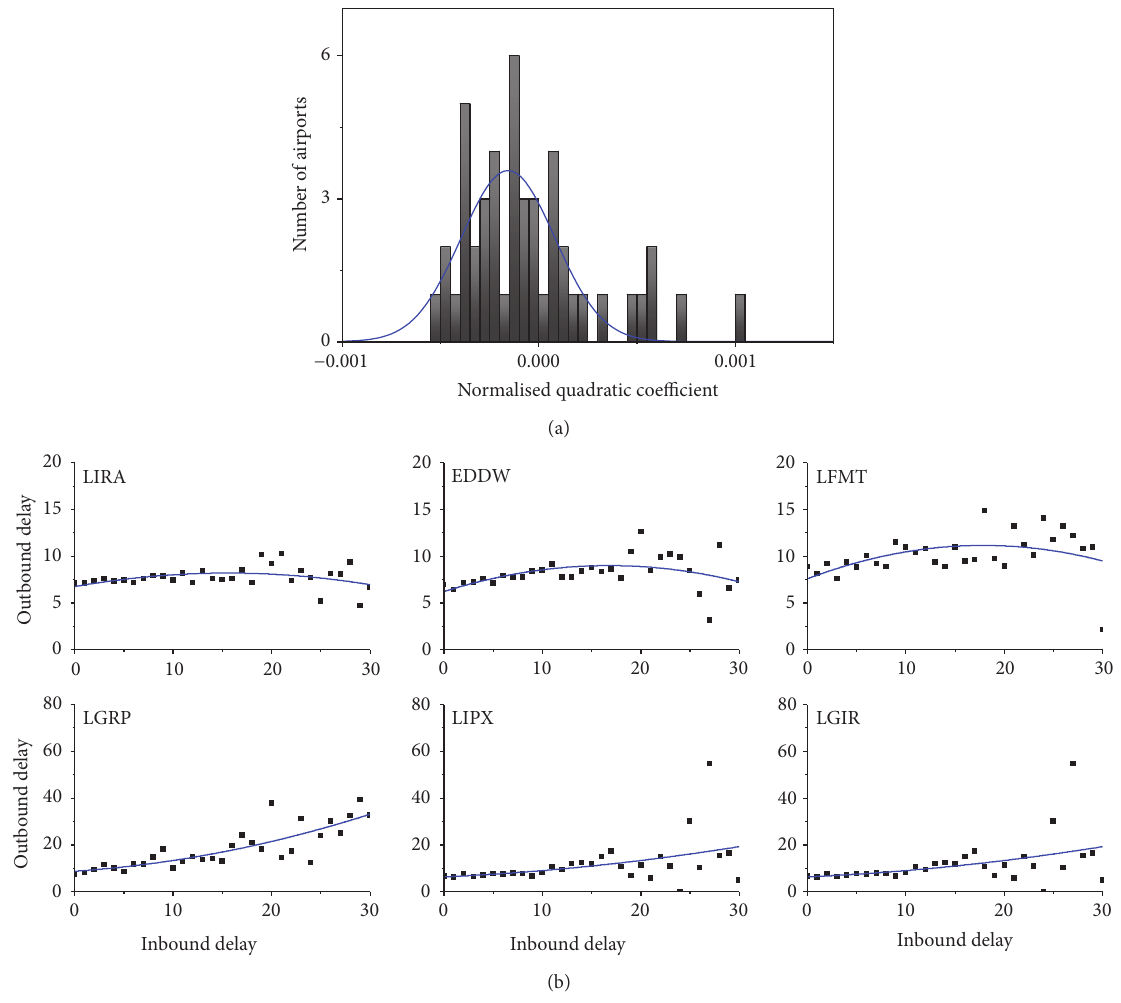
Figure 4: Global behaviour of the European system. (a) represents the histogram of quadratic coefficients for the top 200 airports and (b) the three airports with lower (top graphs) and higher (bottom graphs) quadratic